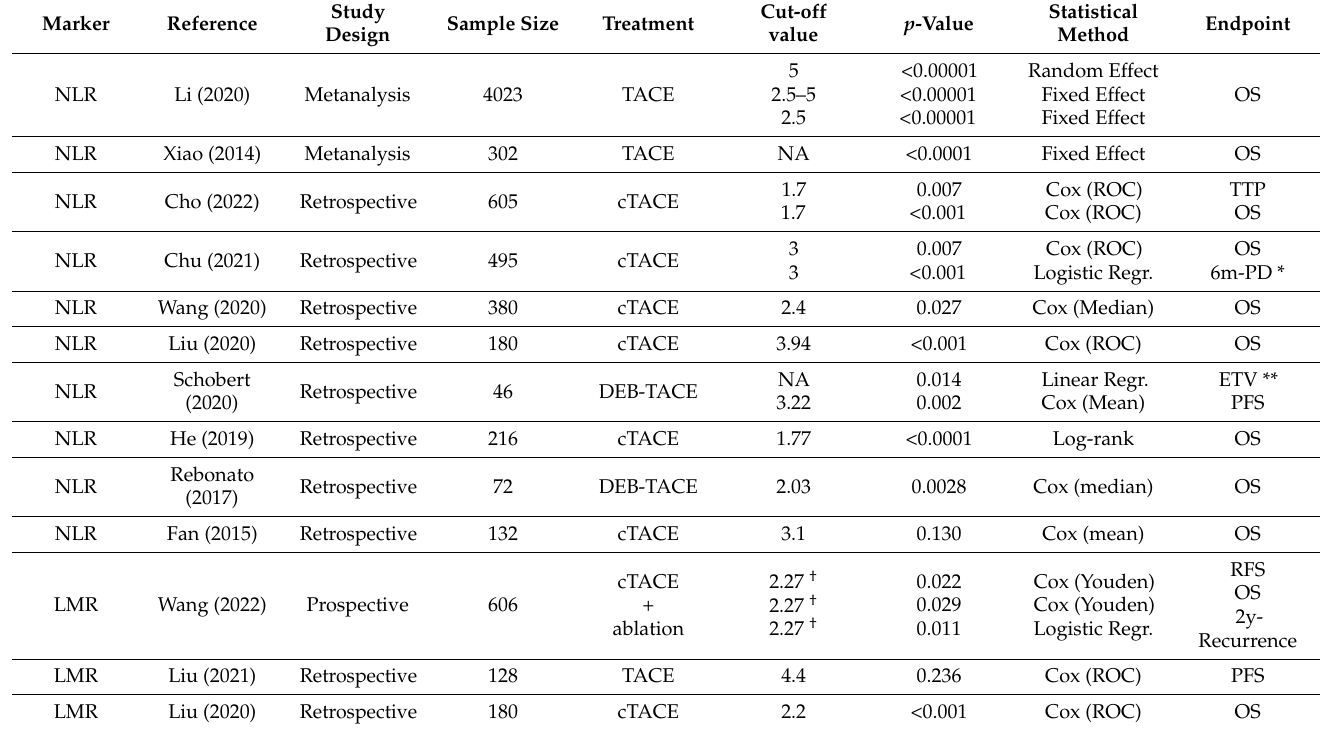
Table 1. Summary table of the main studies included in the literature review that evaluated the prognostic role of preoperative inflammation-based